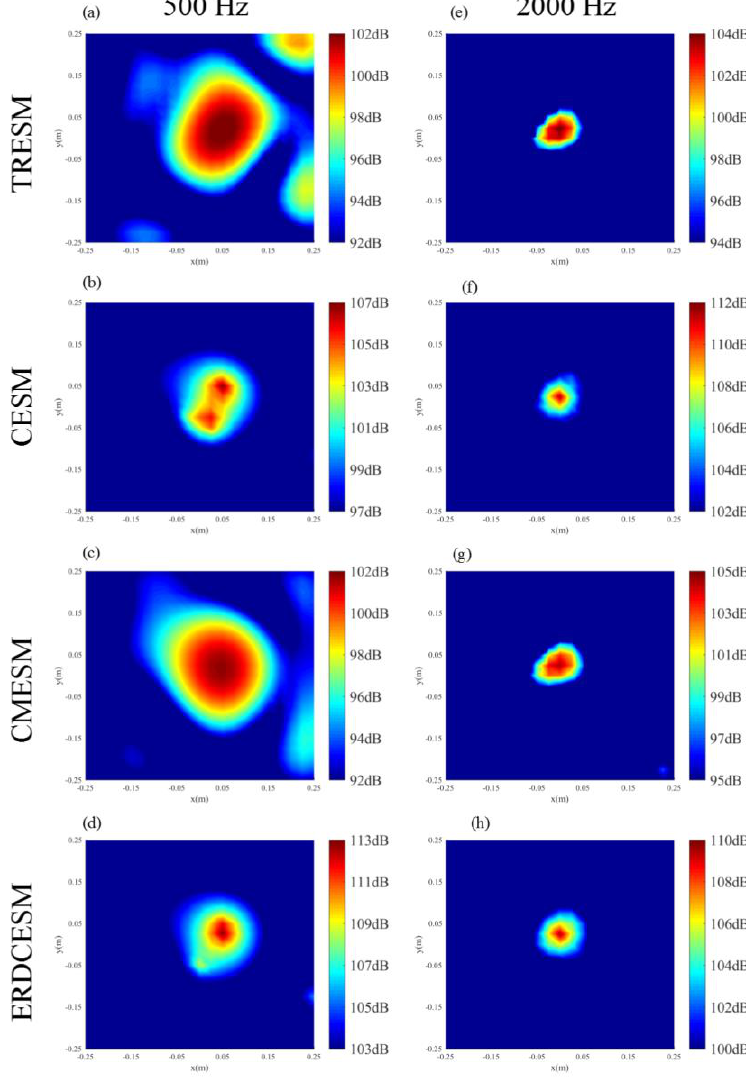
Figure 10. The Experimental results of ( a ) TRESM map at 500 Hz, ( b ) CESM map at 500 Hz, ( c ) CMESM map at 500 Hz, ( d ) ERDCESM map at 500 Hz, ( e ) TRESM map at 2000 Hz, ( f ) CESM map at 2000 Hz, ( g ) CMESM map at 2000 Hz and ( h ) ERDCESM map at 2000 Hz for a single source.